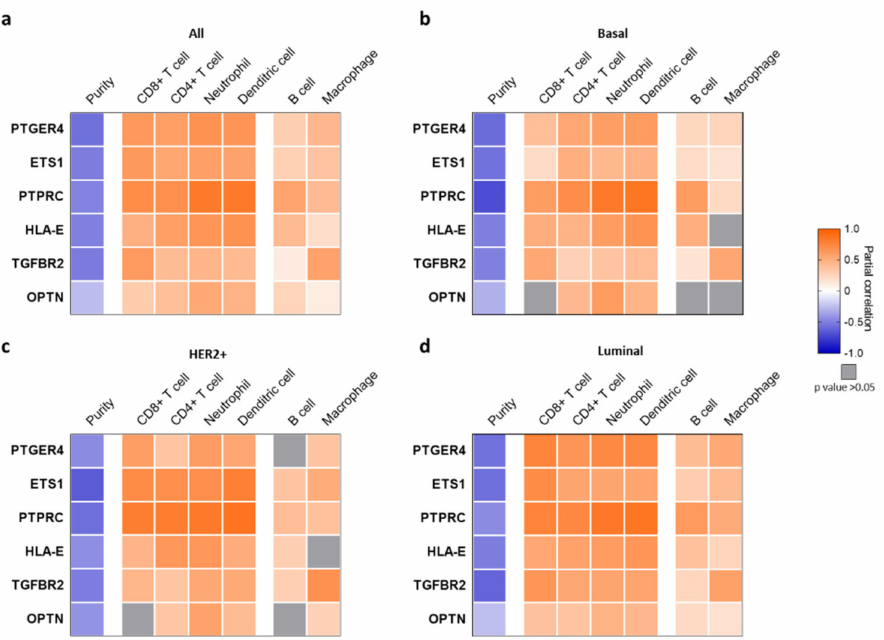
Figure 3. Association of the expression of the selected genes with immune infiltrates in breast cancer. Heat map depicting the Pearson correlation coefficient (R) between gene expression (PTGER4, ETS1, PTPRC, HLA-E, TGFBR2, and OPTN), tumor purity, and the presence of tumor immune infiltrates in ( a ) all, ( b ) basal-like, ( c ) HER2+, and ( d ) luminal breast cancer tumors using TIMER. Tumor immune infiltrates were separated into two groups: first, CD8+ T cells, CD4+ T cells, neutrophils, and dendritic cells (DCs); second, B cells and